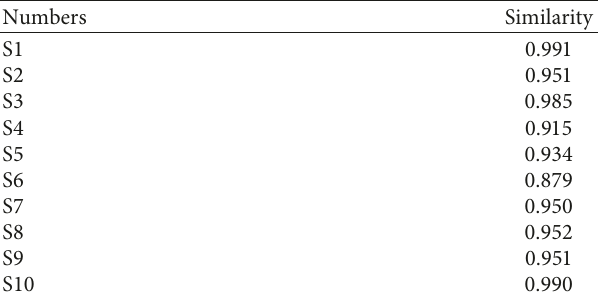
Figure 3: The chromatogram of ethyl acetate extract of S. spatulifolius . Table 4: 10 batches of ethyl acetate extracts from S. spatulifolius similarity evaluation